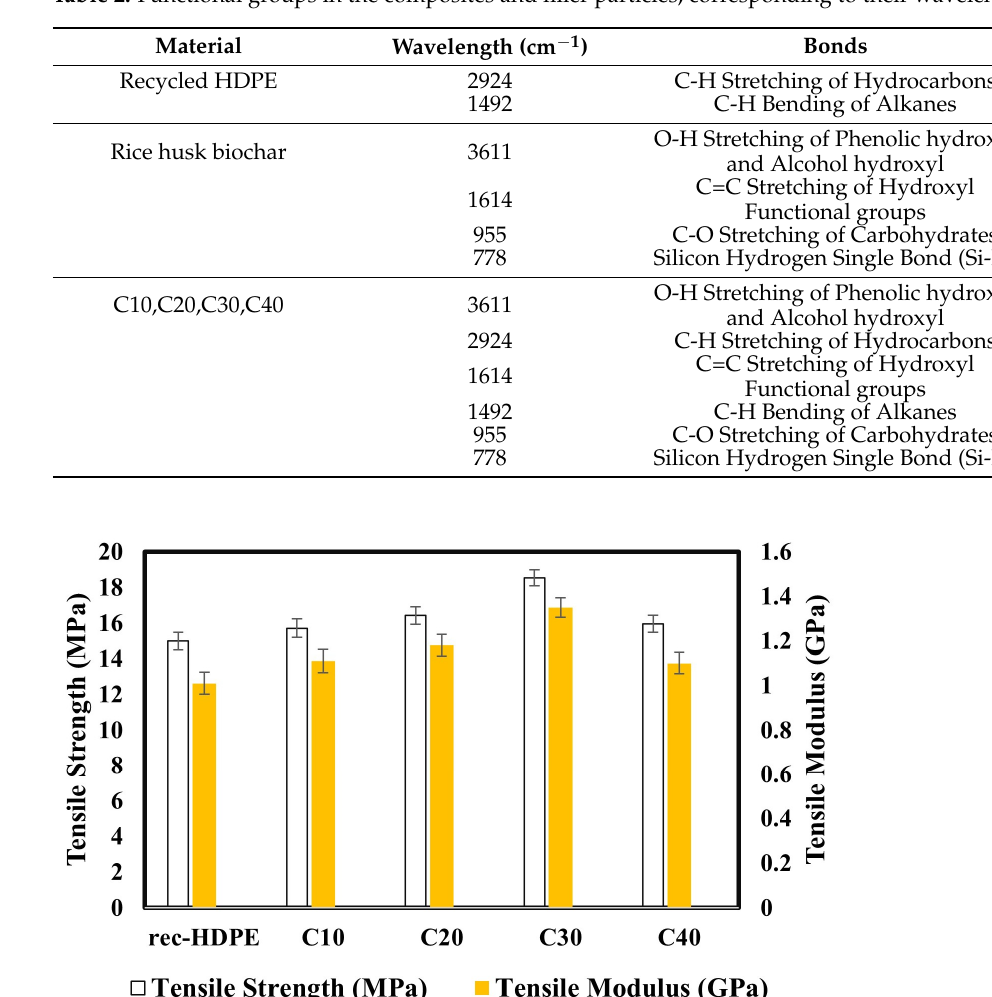
Figure 1. FTIR of recycled HDPE and all composites. Table 2. Functional groups in the composites and filler particles, corresponding to their wavelength.